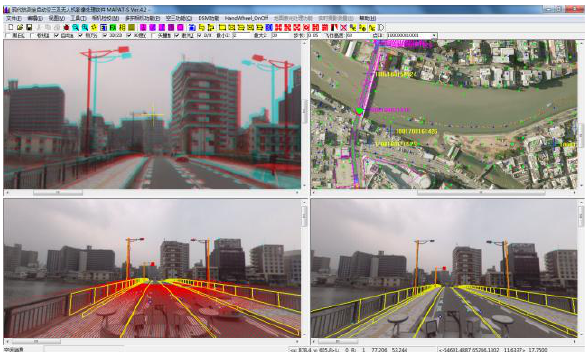
Figure 2. MAPAT-S 4.2 software and aero/MMS hybrid image and laser data process simultaneously (Left up view for aero/ MMS images stereo measurement; Left down view for left aero/MMS image mono measurement; Right down view for right aero/MMS image mono measurement; and Right up view for MMS’s trajectory display or aero image bird